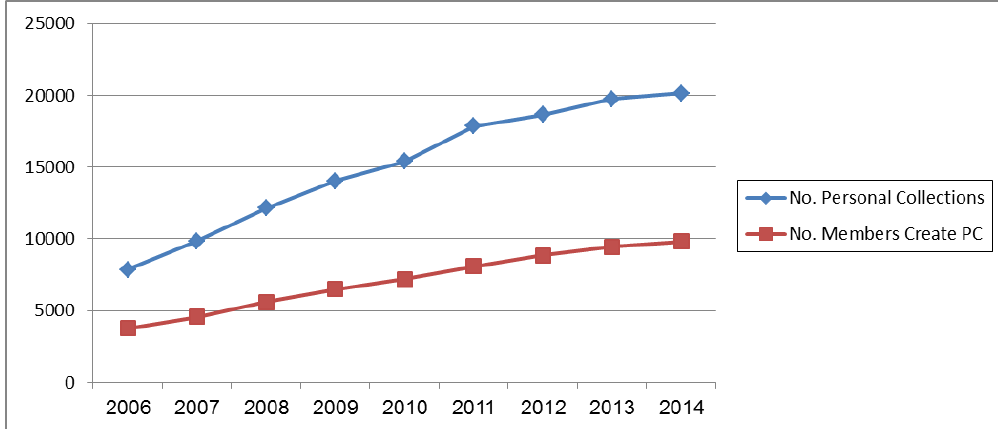
Figure 2. Growth rate of Personal Collections and their creators The Bookmark Collection